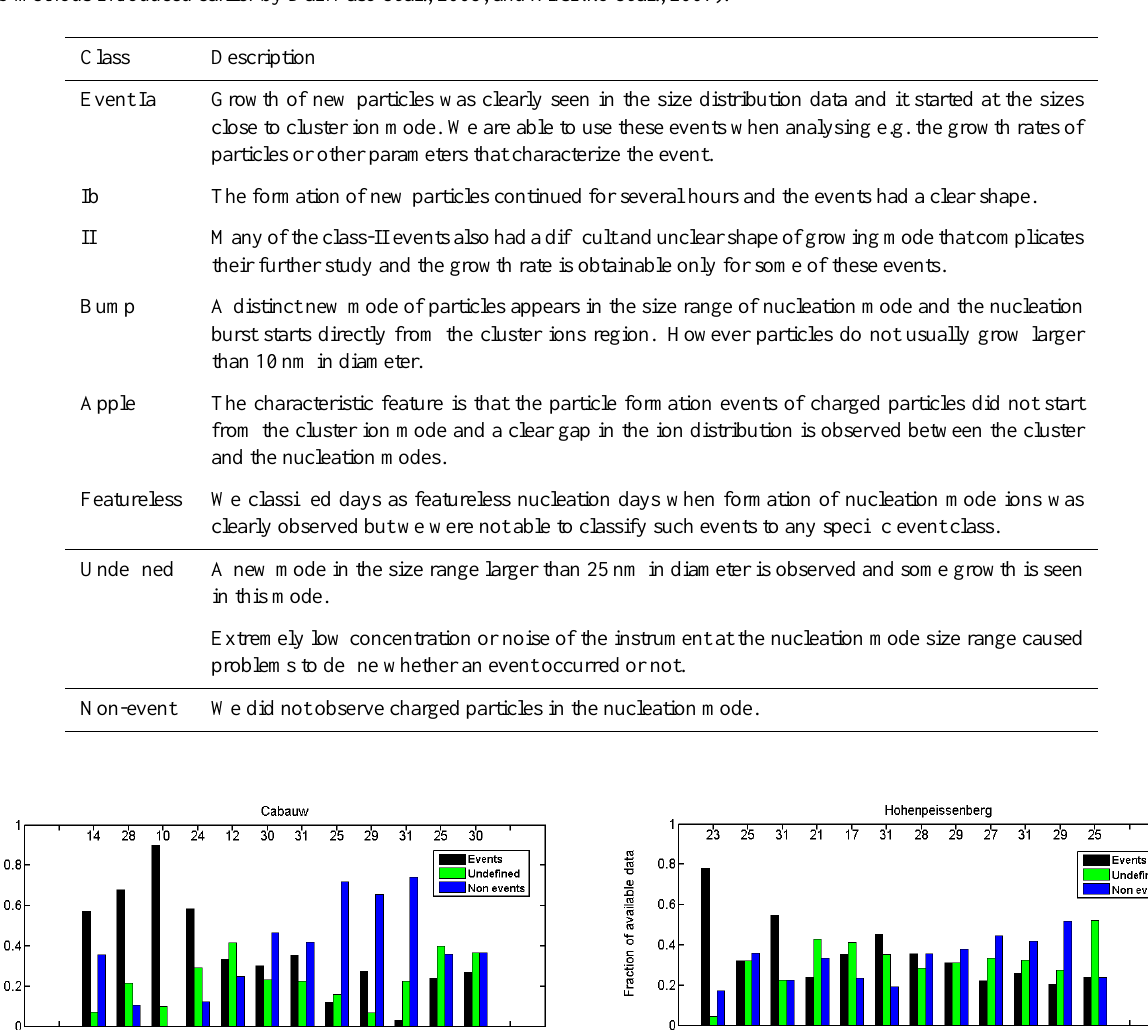
Table A1. The classification of different particle formation event, undefined and non-event days based on the ion spectrometer data (accord- ing to methods introduced earlier by Dal Maso et al., 2005, and Hirsikko et al., 2007).